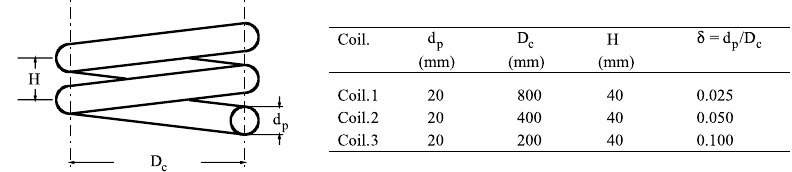
Fig. 4 Schematic representation with geometrical details of helical pipe test sections.